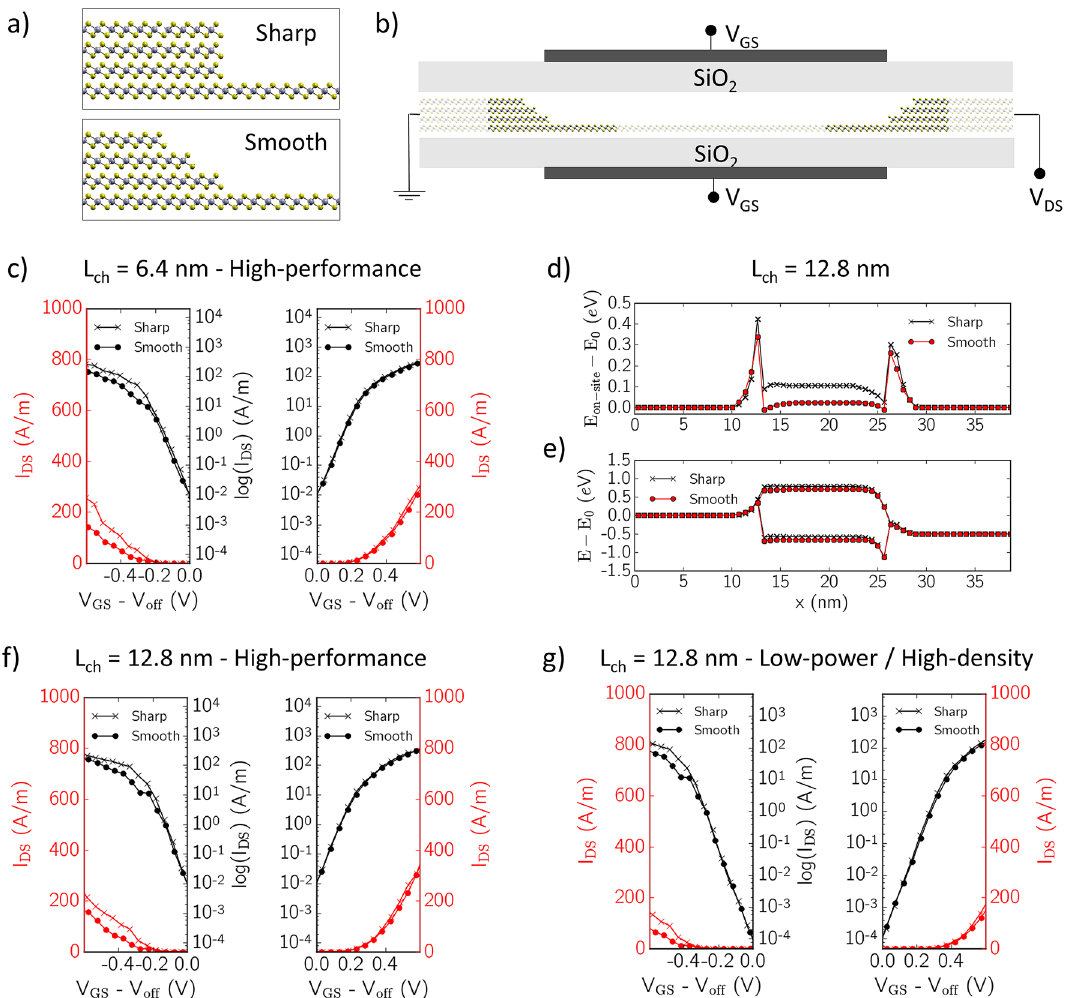
Figure 5. Far-from-equilibrium transport simulations of 4L-1L PtSe 2 heterostructures. ( a ) Lateral ( xz ) view of sharp and 3-nm smooth interfaces. ( b ) double-gate FET configuration. ( c ) Transfer characteristics for a 6.4 nm long 1L channel in a FET with 4L leads and sharp (crosses) or smooth (circles) interfaces, optimized for HP processes. Red curves are in linear scale and black curves are in semilogarithmic scale. The n- (p-) branch is shown on the right (left). ( d ) On-site energy E on-site along the heterostructures with sharp (black) and smooth (red) interfaces between the 4L leads and a 12.8 nm long 1L channel. E 0 = E on-site ( x = 0) . ( e ) Valence and conduction band diagrams for the latter devices at V GS = 0 and V DS = 0.5 V. ( f ) Transfer characteristics for the 12 nm-long channel FETs, optimized for HP processes. ( g ) Transfer characteristics for the 12-nm-long channel optimized for HD processes. All results have been obtained by mapping E on-site from DFT. This figure was made using VMD [v1.9.1, https:// www. ks. uiuc. edu/ Resea rch/ vmd/ vmd-1. 9.1] and Matplotlib [v3.3.3, https:// doi. org/ 10. 5281/ zenodo. 42689